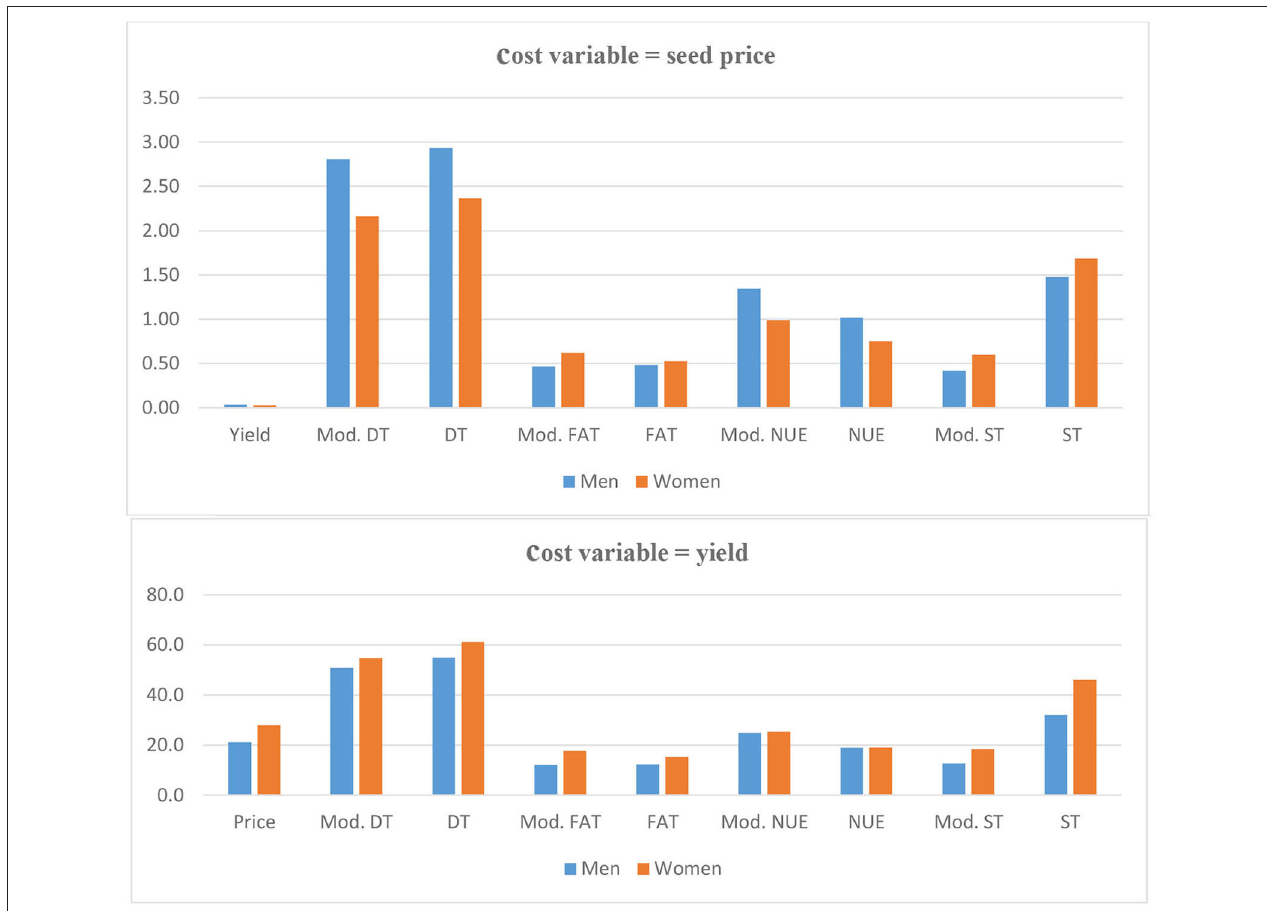
FIGURE 4 | Differences between men and women in WTP and WTSY for maize